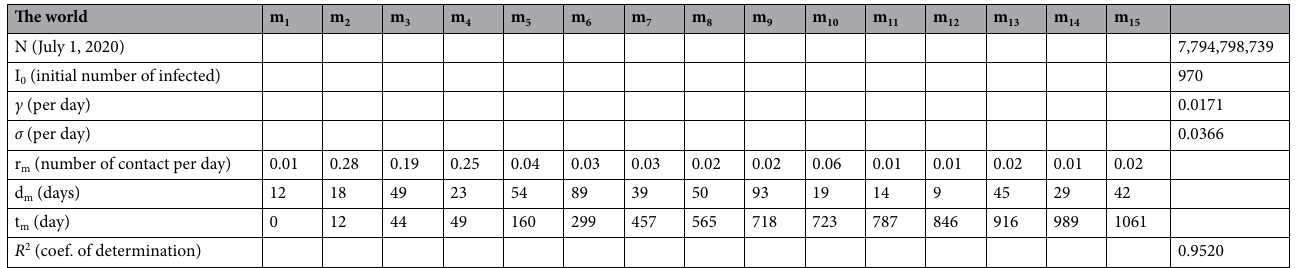
Table 1. Parameter estimation of multiple waves model of COVID-19 for the world (observed data from 22 January 2020 to 13 February 2023).